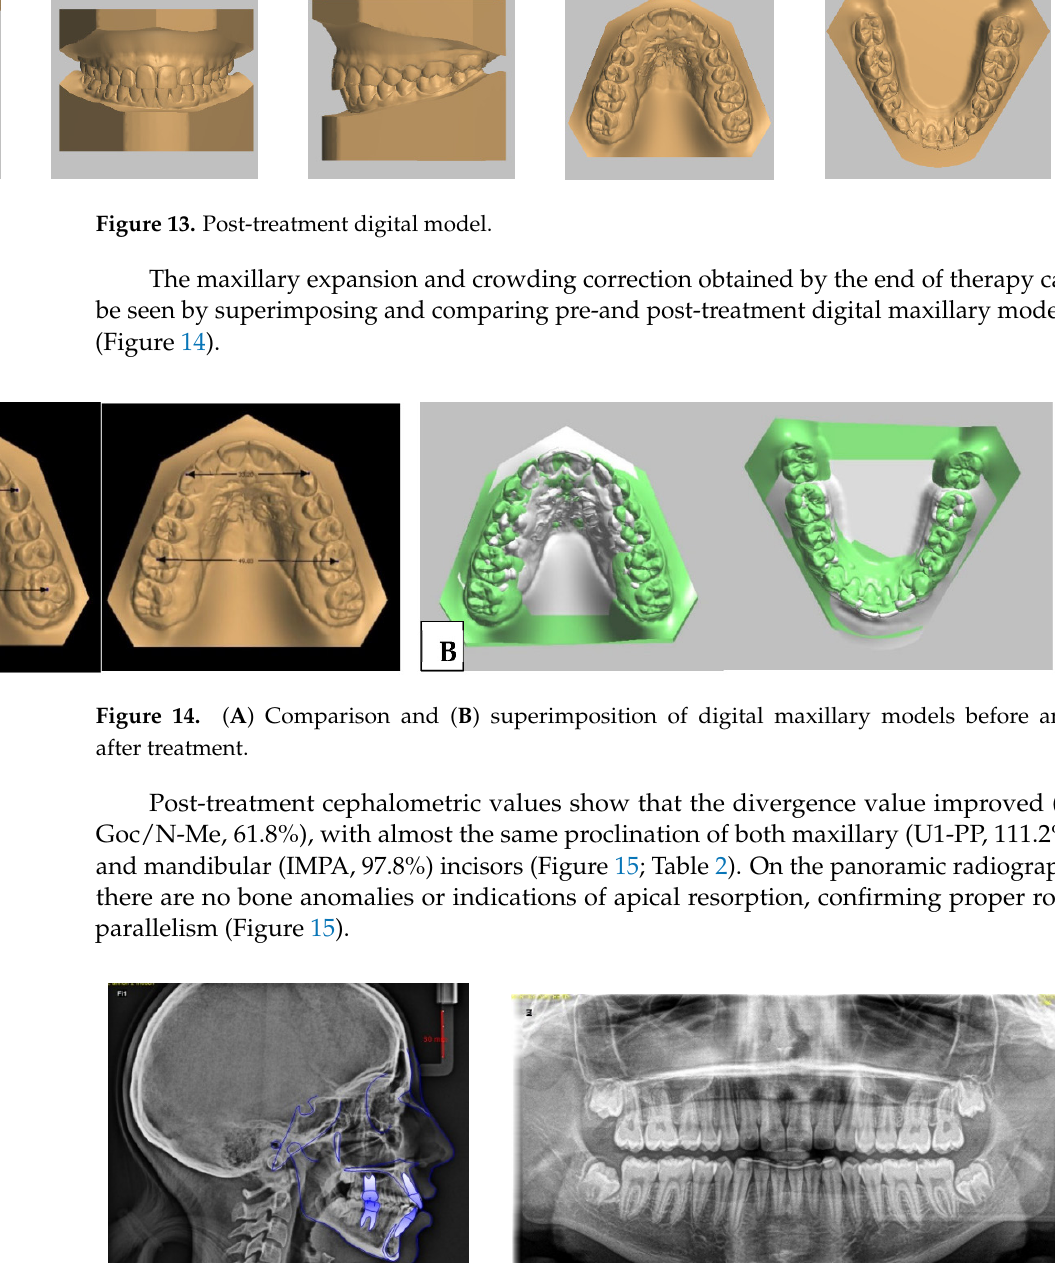
Figure 16. Cephalometric superimpositions (blue, pre treatment; red, post treatment). 5. Discussion The goal of this paper was to analyze how palatal expansion is performed in adoles- cent patients, and the effects of various palatal expansion equipment on hard and soft oral tissues. First described by Angell in 1860 [43], the tooth-borne maxillary expander is still widely used by clinicians to solve transversal discrepancies in the maxilla [23]. Hyrax design appliances are the most commonly used: they present bands on U6 and maxillary first premolars and a 9 mm expansion screw. Mini Hyrax design appliances present only two bands, and the first molars are the anchorage elements; the screw is 8 mm long [26]. Silveira et al. stated that Hyrax and Mini-Hyrax devices are similar in terms of orthodontic and orthopedic effects and patient’s comfort [26]. The force produced when the screw is activated involves the widening of the palatine suture but also has effects on other craniofacial structures, on the upper airways [31,35,36], and soft tissue [24], and produces dentoalveolar changes.